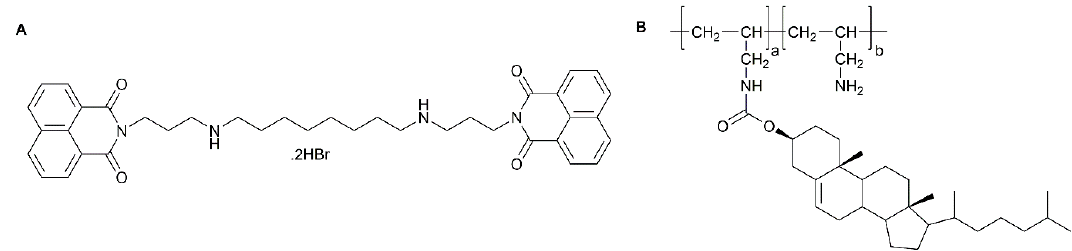
Figure 5. Chemical structure of ( A ) poly(allylamine)-cholesterol and ( B ) bisnaphthalimido propyldiaamino octane.